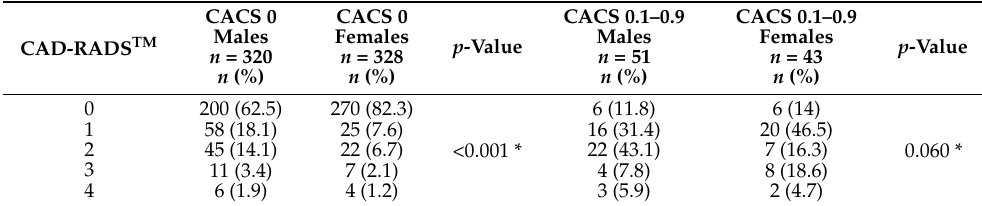
Table 3. Same as above after propensity score matching+ ( n = 742); CAD-RADS TM —CTA Stenosis severity.